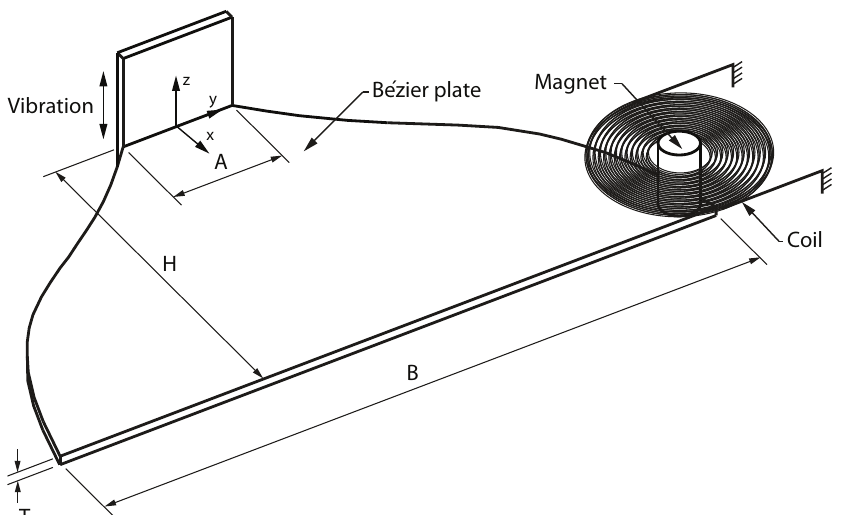
Figure 1. Schematic of a Bézier plate with a magnet fixed to a corner of the plate’s longer edge. Voltage is generated in the coil according to Faraday’s law of induction.